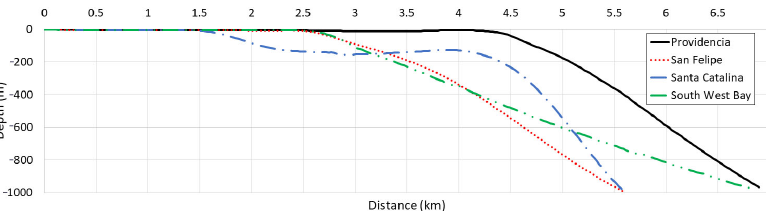
Figure 12. Profiles at seven points of Providencia and Santa